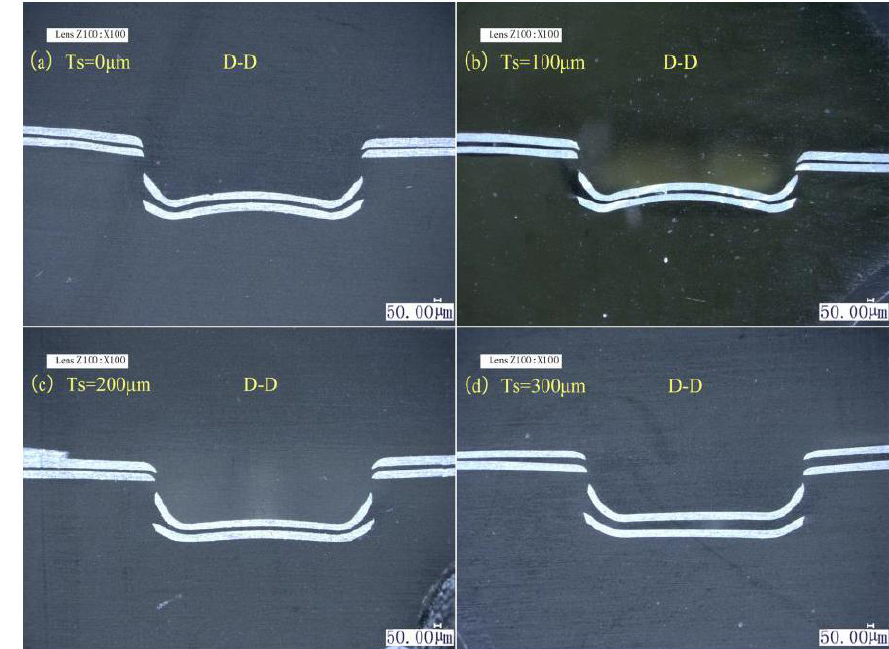
Figure 5. D–D section of preliminary joints with four different thicknesses of the soft punch: ( a ) Ts = 0 μm; ( b ) Ts = 100 μm; ( c ) Ts = 200 μm; ( d ) Ts = 300 μm.